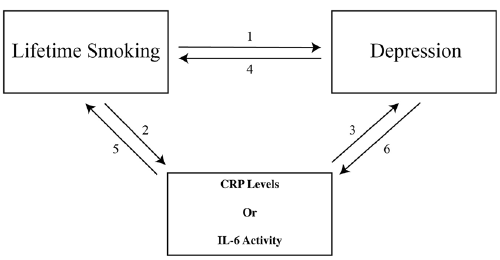
Figure 1. Graphic representation of the different univariable MR analyses performed. The. numbers for the different analyses correspond to those listed in Table